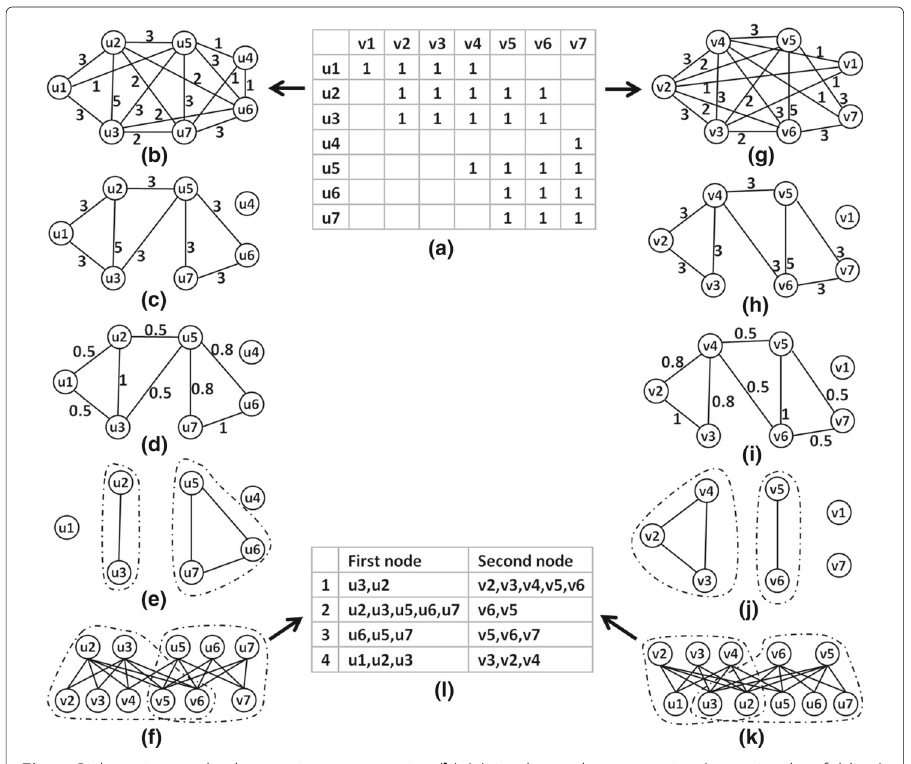
Fig. 1 Biclustering method. a matrix representation ( b )-( e )simple graph construction (row wise data folding); g - j simple graph construction (column wise data folding); e , j applying DPClusO; f , k second node attachment; l join cluster